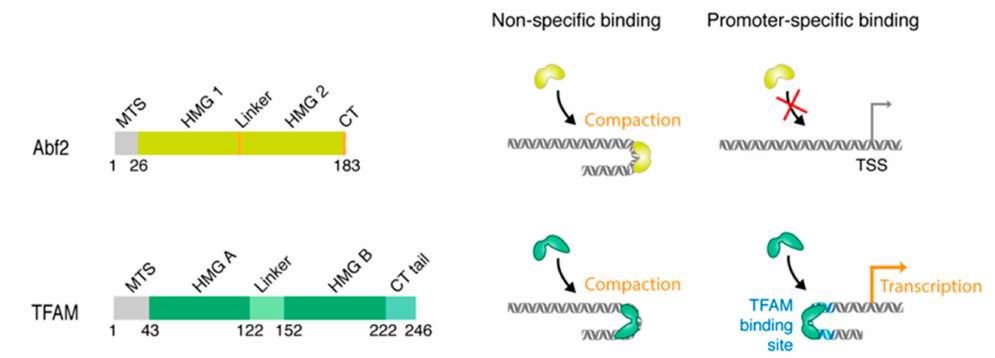
Figure 2. Comparison of yeast Abf2 and human TFAM. Left panels: Protein architecture of Abf2 (yellow) and TFAM (green) showing the mitochondrial targeting sequence (MTS), HMG boxes A and B, linker, and C-terminus. Middle panels: Abf2 and TFAM bind to DNA (grey duplex) non-specifically and induce compaction. Right panels: Abf2 has no promoter-specific binding activity and does not function as a transcription factor. Mammalian mitochondrial promoters have TFAM binding sites (blue duplex) to which TFAM can bind specifically and activate transcription. TSS- transcription start